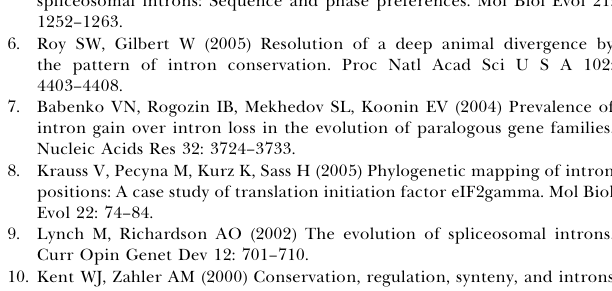
Figure S3. Similarity in Orthologous Intron Lengths Is Little Influenced by the Intensity of Selection on Flanking Exons x -axis, average D. melanogaster – D. yakuba K a /K s for each pair of exons flanking each orthologous intron pair. y -axis, fractional difference in length of the corresponding orthologous D. melanogaster – D. yakuba intron pair, L c ; where L c ¼ [(L i þ L j ) (cid:1)j L i – L j j ] / (L i þ L j ); and L i and L j refer to length of orthologous introns i, and j, respectively. If the two introns are the same length, L c equals 1. If one member of the pair is twice the length of the other, L c equals 0.5. Thus L c provides a simple means to associate a similarity value with each pair of orthologous introns. For purposes of display 1 (cid:1) L c is plotted so that two introns having exactly the same length, flanked by exons with a K a /K s ¼ 0 will lie at the graph’s origin. Orange line, best-fitting linear regression (y ¼ 0.0457x þ 0.0863; R 2 ¼ 0.0015). No significant Spearman correlation coefficient was observed for these data. Found at DOI: 10.1371/journal.pcbi.0020015.sg003 (2.6 MB